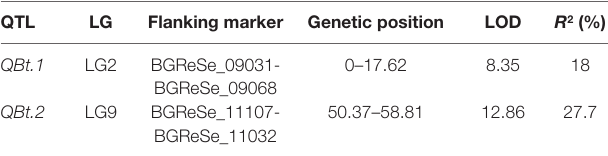
TaBle 2 | QTLs for fruit bitterness detected in the 2014 F 2